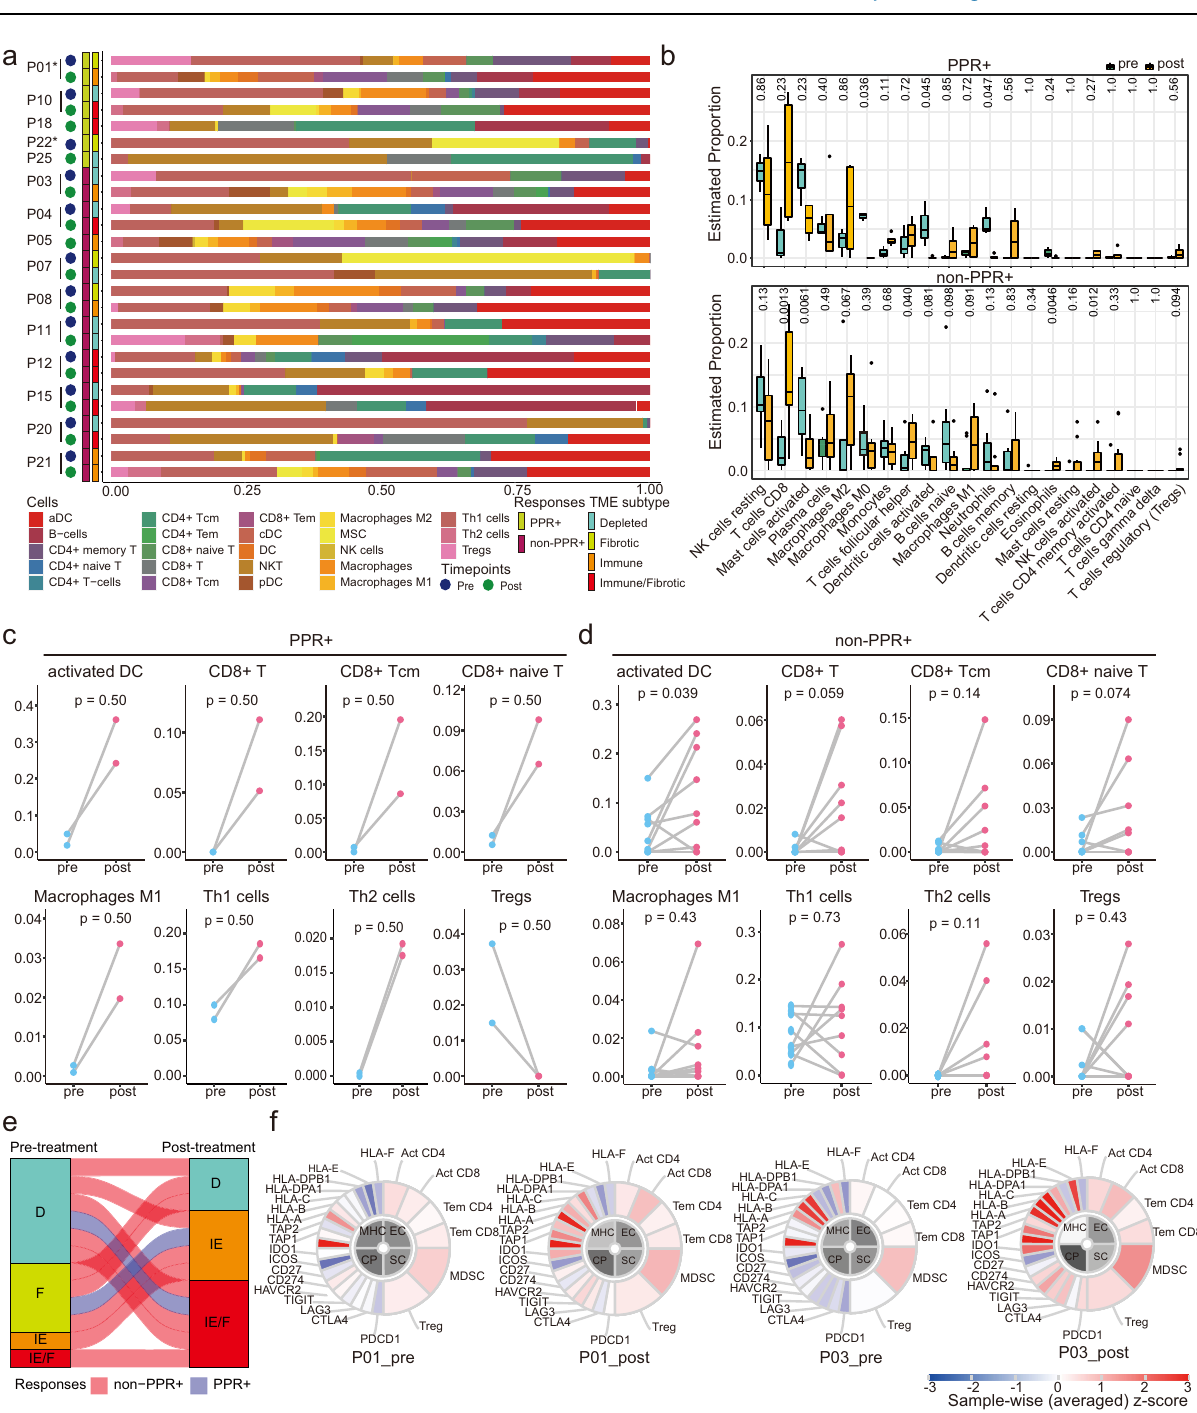
Fig. 5 | Immune cell deconvolution and association with responses to neoad- juvant therapy. a Abundance of in fi ltrated cells estimated by xCell in 15 patients. b Changes in proportions of 21 immune cell types from pre- to post-treatment samples in PPR+ (top, n =3 and 4) and non-PPR+ (bottom, n =9 and 10) patients, estimated by Cibersort. Centers, boxes, whiskers, and dots indicate medians, quantiles, minima/maxima, and outliers, respectively. Two-sided Wilcoxon rank- sum test was used with no adjustments for multiple comparisons. c-d Changes in proportionsofimmunecellsfrompre-topost-treatmentsamplesinPPR+( c , n =2)